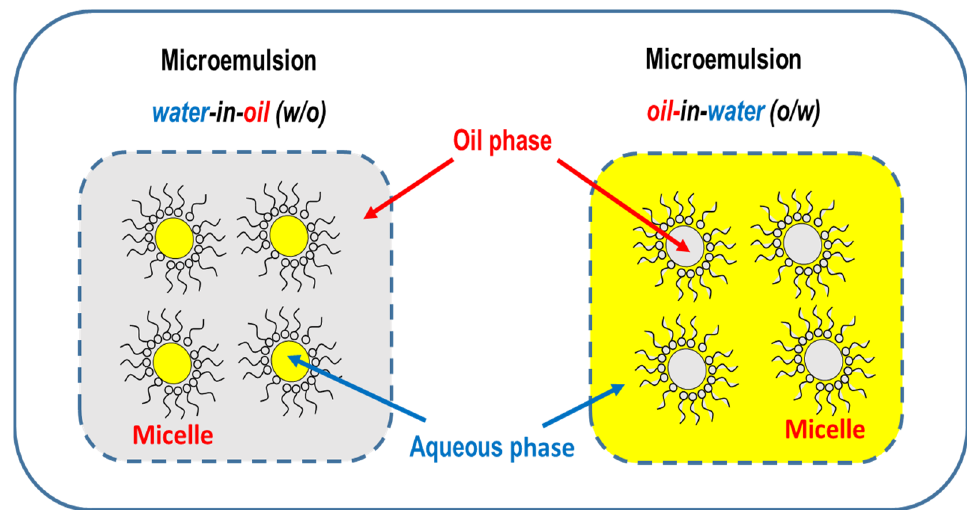
Figure 19. Water-in-oil and oil-in-water microemulsions.